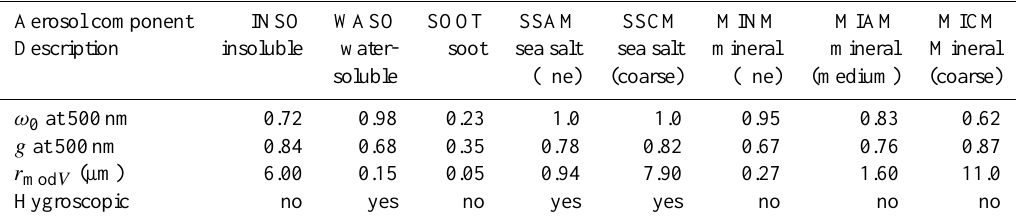
Table A1. List of GADS aerosol components. Data are borrowed from Koepke et al. (1997) and Hess et al. (1998). Parameter r mod V (µ m ) is the mode radius of the volume